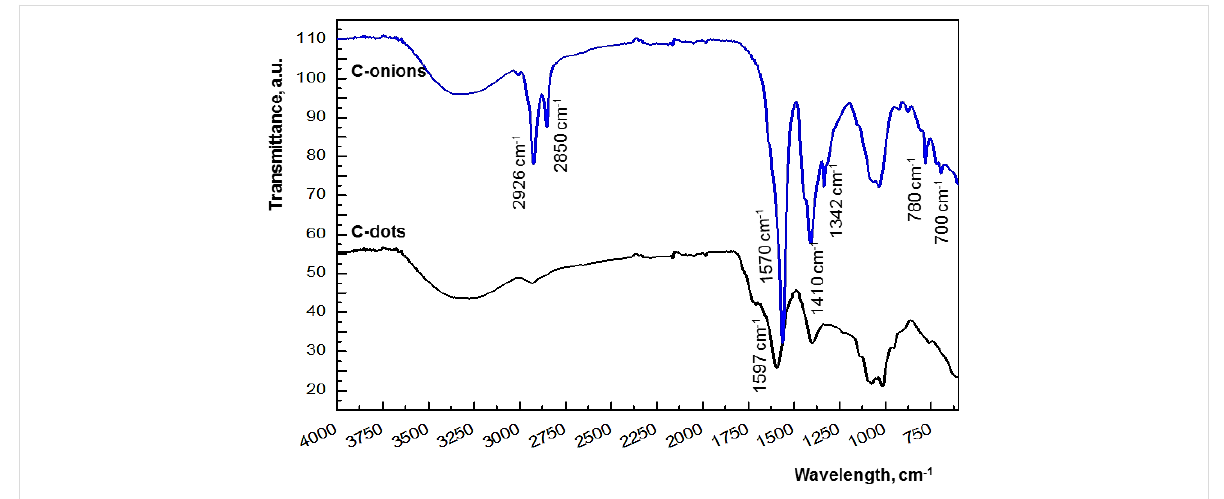
Figure 5: FTIR spectra of C-dots and C-onions obtained by carbonization of tomatoes in aqueous solution and NaOH 30% (w/v), respectively.